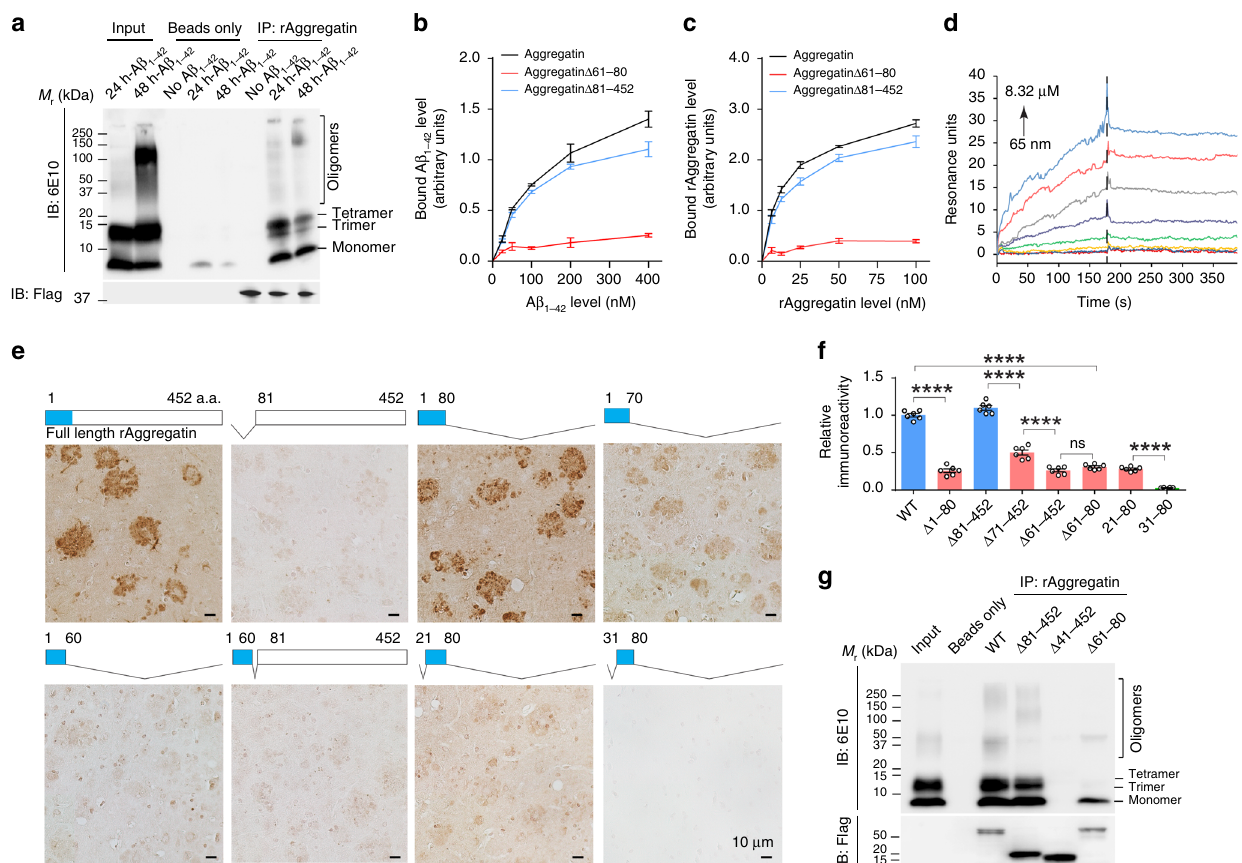
Fig. 3 Aggregatin interacts with A β . a Coimmunoprecipitation of puri fi ed Flag-tagged rAggregatin and A β 1 – 42 (pre-aggregated in vitro for 24 or 48 h). rAggregatin was immunoprecipitated using streptavidin magnetic beads and immunoblotted using the antibody to Flag. b Measurement of A β 1 – 42 levels bound to immobilized rAggregatin (normalized to maximal rAggregatin and A β 1 – 42 binding). n = 3 independent experiments. c Measurement of rAggregatin levels bound to immobilized A β 1 – 42 (normalized to maximal rAggregatin and A β 1 – 42 binding). n = 3 independent experiments. d Bio-layer interferometry measurement of the binding kinetics of monomeric A β 1 – 42 to immobilized rAggregatin. Curves are corresponded to A β 1 – 42 at 8320, 4160, 2080,1040, 520, 260, 130 and 65 nM from the top to bottom. e , f Representative immunohistochemistry ( e ) and quanti fi cation ( f ) of rAggregatin immunoreactivity (Flag antibody) in 5XFAD mouse brain sections after incubation with 100 nM indicated rAggregatin deletion mutants ( n = 6 independent experiments in each group). Blocks with blue color on the top of each immunohistochemistry image show NABD. g Coimmunoprecipitation analysis of puri fi ed Flag-tagged rAggregatin deletion mutations and A β 1 – 42 using streptavidin magnetic beads. Source data are provided as a Source Data fi le (Source Data for Statistics and Blots). Data are means ± s.e.m (± is the plus – minus sign). One-way analysis of variance (ANOVA) followed by Tukey ’ s